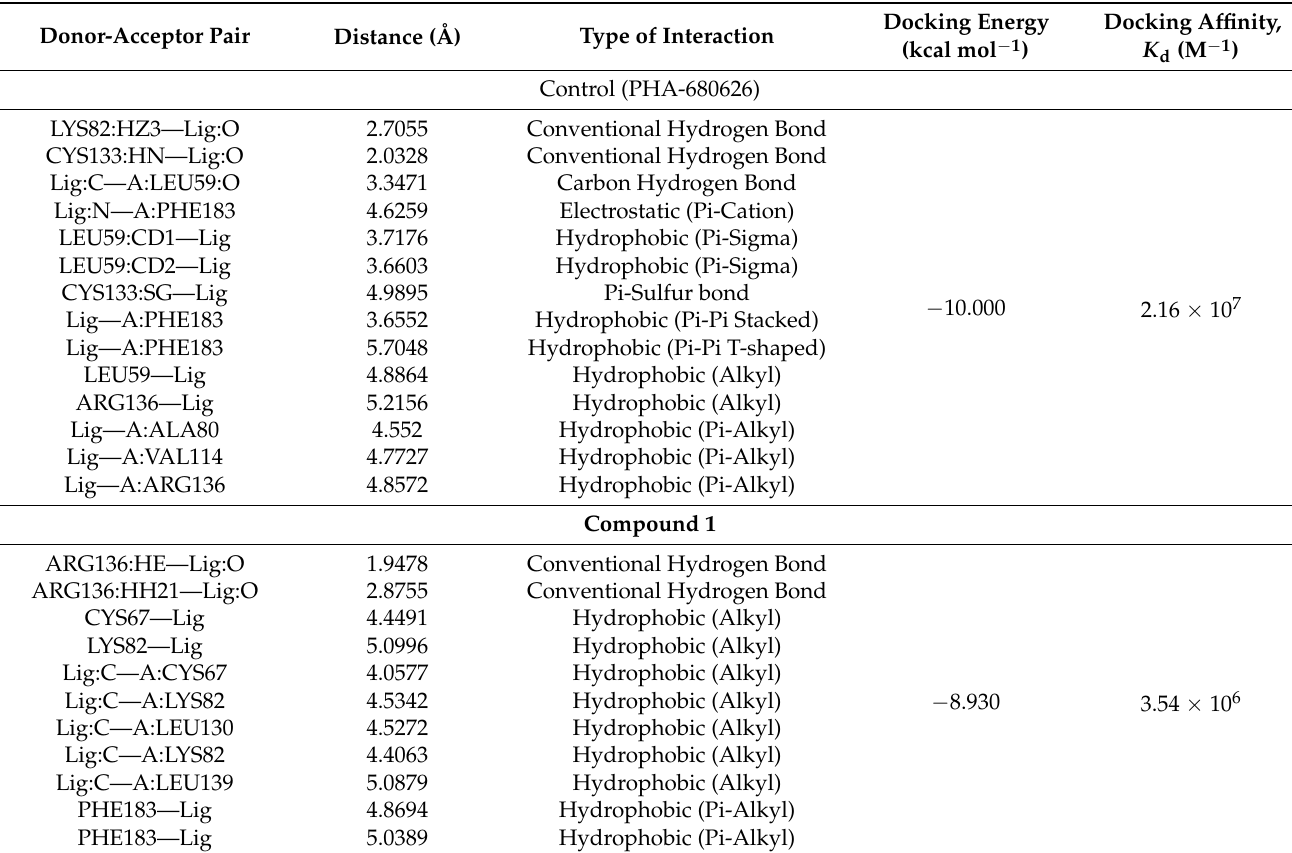
Figure 4. Molecular docking of PHA-680626 to the catalytic domain of Polo-like kinase 1 (PLK-1). ( A ) 2D representation of the binding of PHA-680626 (control ligand) at the ATP binding site of PLK-1, ( B ) binding of PHA-680626 (control ligand) at the ATP binding cavity of PLK-1, and ( C ) molecular interaction between PLK-1 and PHA-680626 (control ligand). Table 2. Molecular docking parameters for compound 1 -polo-like kinase (PLK-1) interactions.